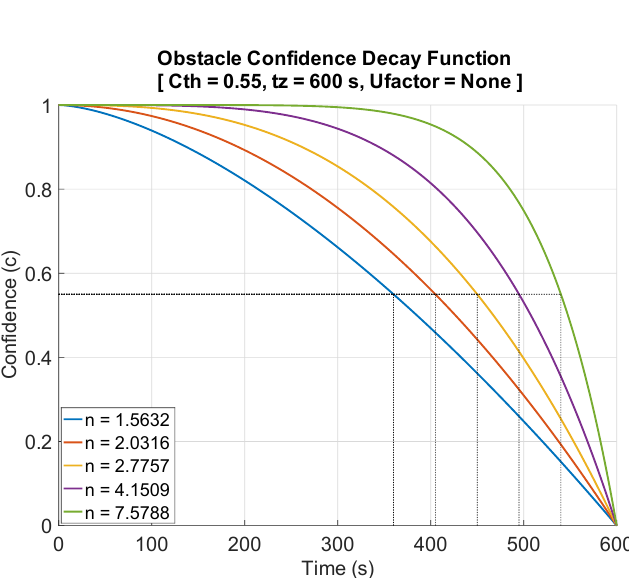
Figure 7. Obstacle confidence decay function. c th = 0.55, t z = 600 s. Effects of uncertainty are not considered and Ufactor =